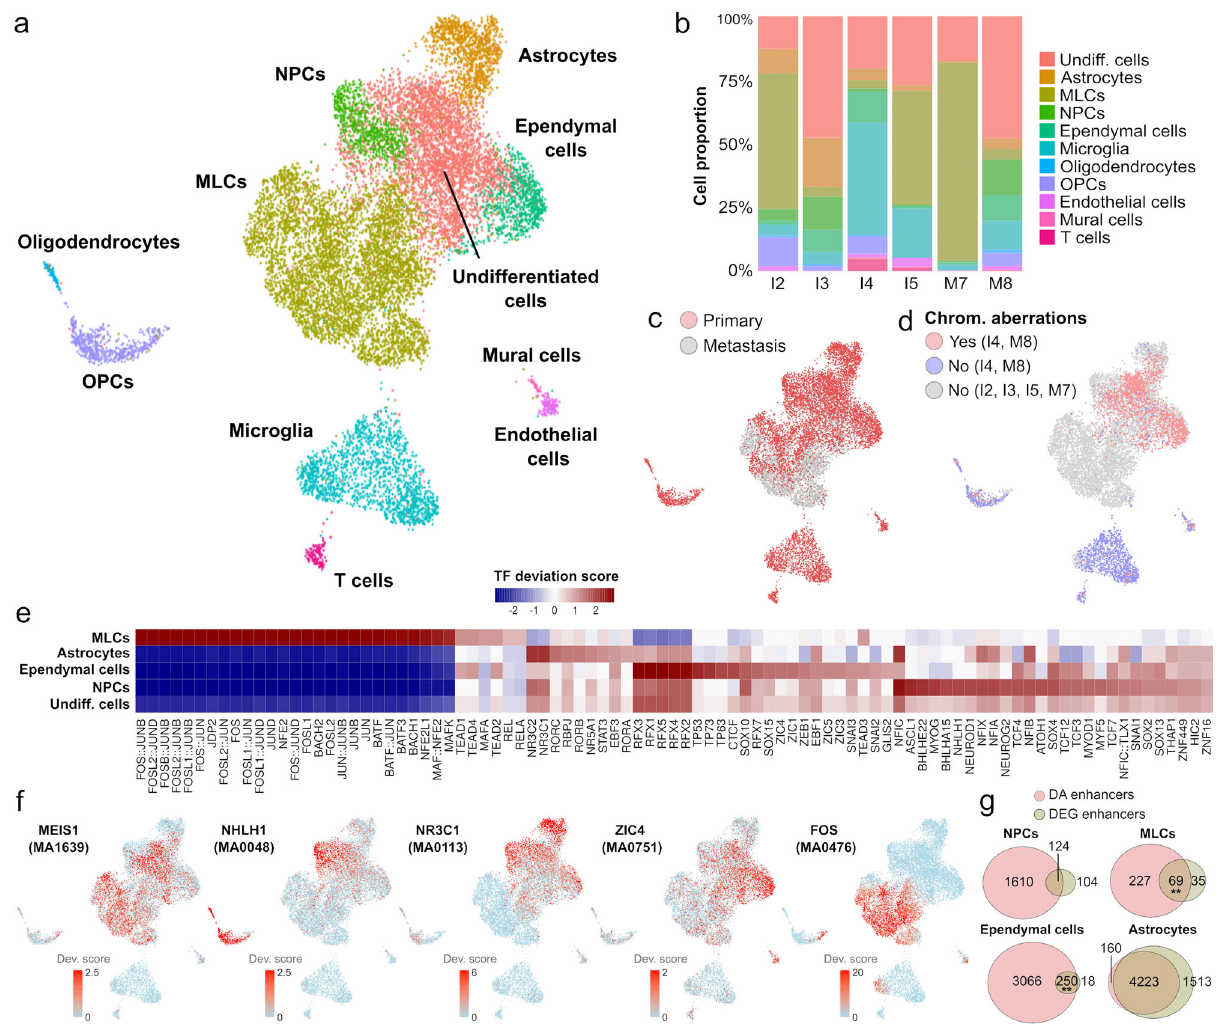
Fig. 3 Single-nucleus ATAC-seq of primary and metastatic ependymal tumors uncovers transcription factors and enhancers associated with the differentiation and EMT of posterior fossa ependymoma. a Single-nucleus ATAC-seq data of 14,461 cells from six primary and metastatic posterior fossa ependymal tumors. The UMAP representation of the data is colored and annotated by the 11 cell populations identi fi ed. b Stacked bar chart showing the proportion of each cell type in each of the six tumors. The UMAP representation is labeled according to the origin (primary/metastasis) of each cell ( c ), and the presence/absence of chromosomal aberrations as inferred from the single-nucleus ATAC-seq data ( d ). e Transcription factor (TF) binding motif accessibility score for TFs with differentially accessible binding motifs (Wilcoxon rank-sum test; FDR < 0.01) in at least one of the tumor cell populations and z -score fold-change Δ z (cid:4) 1. f The UMAP representation is colored by the TF binding motif accessibility score of fi ve representative TFs that are signi fi cantly associated with individual tumor cell populations and are discussed in the main text. The JASPER database ID for the corresponding motif is indicated in parenthesis. g Venn diagrams showing the overlap between differentially accessible (DA) enhancers and enhancers associated with differentially expressed genes (DEGs) in tumor-derived cell populations. The number of enhancers in each class and the level of signi fi cance for the association are indicated (two-sided Fisher ’ s exact test; ** p value (cid:3) 0 : 01). Numeric p values for MLCs and ependymal cells are 0.0016 and 0.0075, respectively. MLCs mesenchymal-like tumor cells, NPCs neural progenitor tumor cells, OPCs oligodendrocyte progenitor